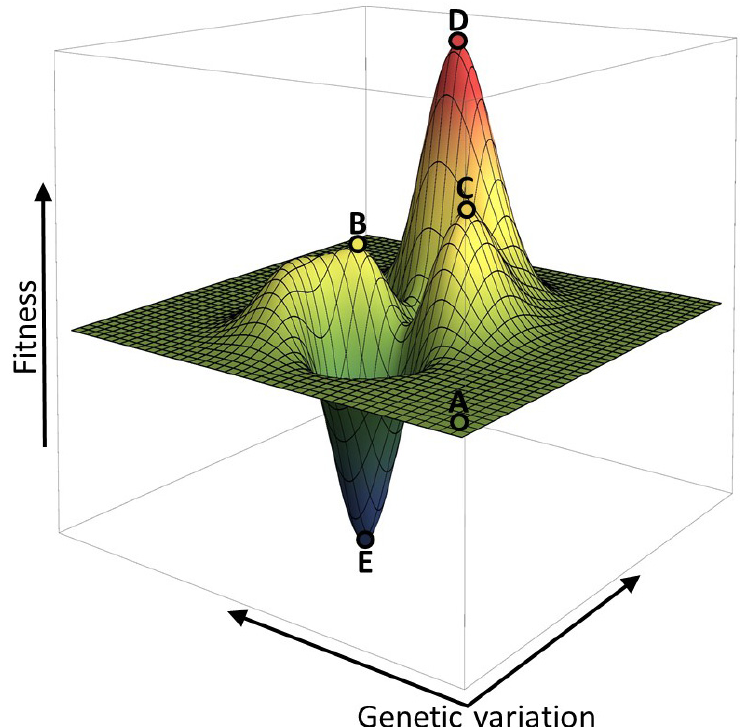
Figure 3. The fitness of an organism is often visualized as an adaptive landscape, with genomic changes ( i.e. , point mutations in genes or regulators) on the x- and y-axes, and fitness on the z-axis. Most mutations are expected to have a neutral (point A) or negative (point E) effect on fitness. Some mutations however can lead to fitness increases (B, C, D). The genetic background of an organism (the location on the landscape), can have a deterministic effect on the adaptive path. For example, it is virtually impossible for an organism at point C to evolve to point D, as it would have to overcome an “adaptive valley”, i.e. , acquire mutations with a negative effect on fitness before it can increase its fitness